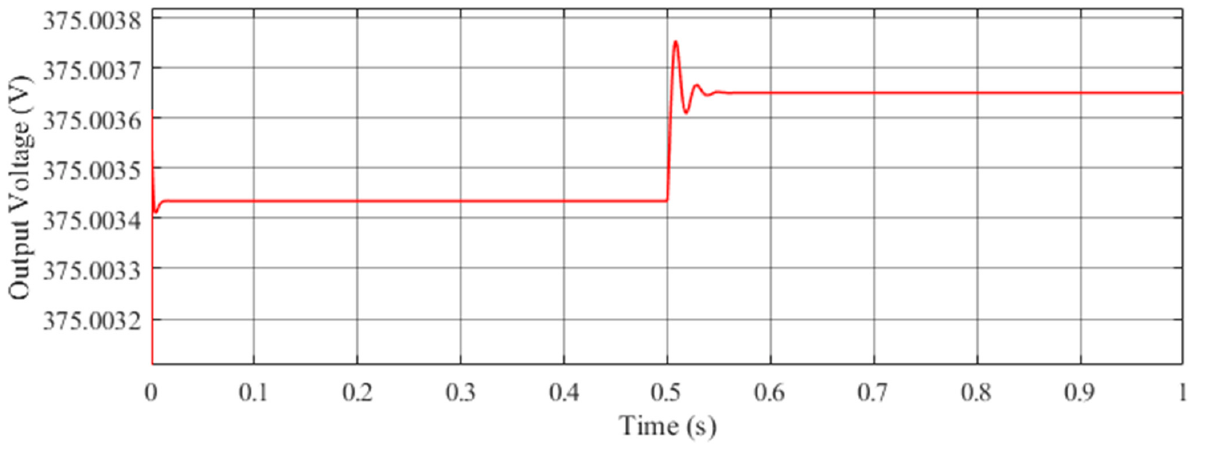
Figure 11. Voltage control with proposed controller during inductive load variations; ( a ) output voltage for inductive load in ABC frame; ( b ) zoomed in view.